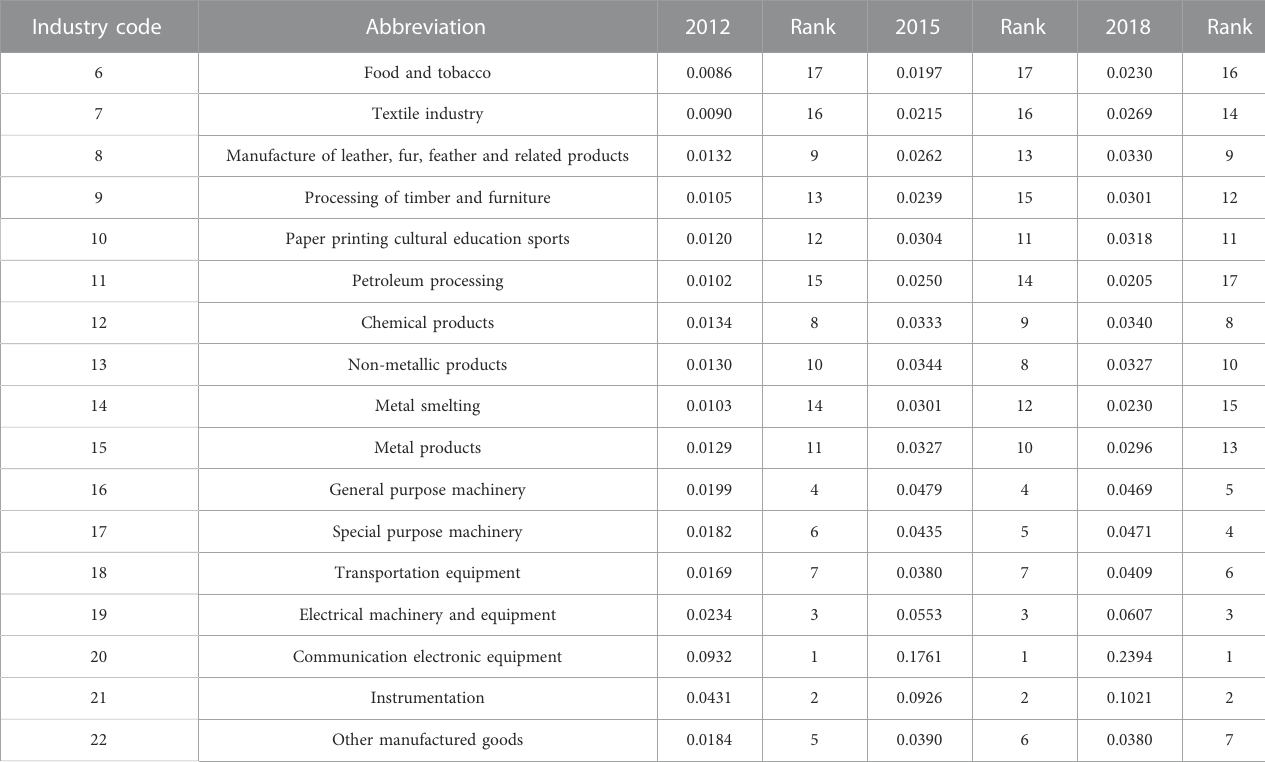
TABLE 3 Measurement results of digital transformation degree of manufacturing industry.